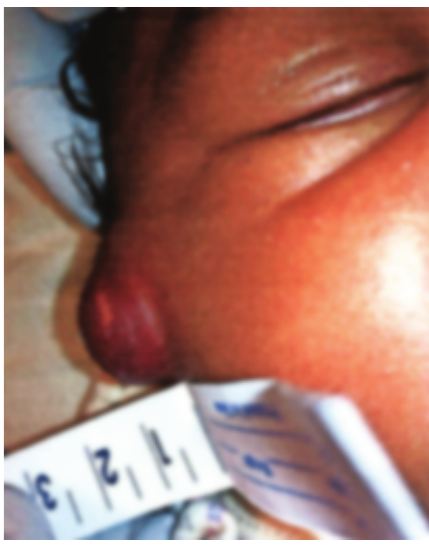
Figure 1: Facial lesion.